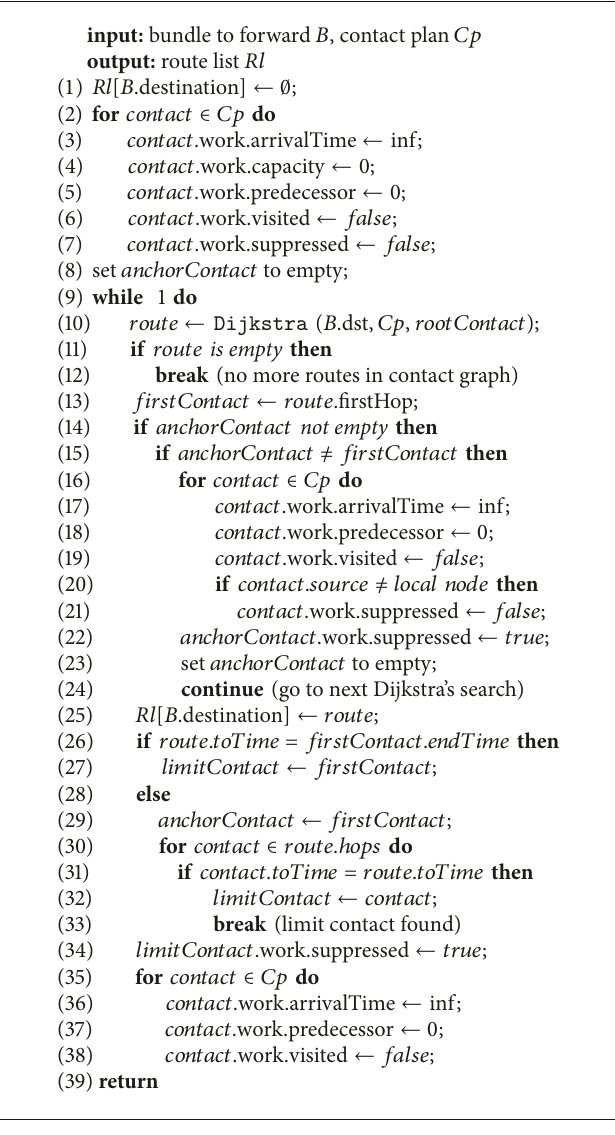
Algorithm 3: CGR: Load route